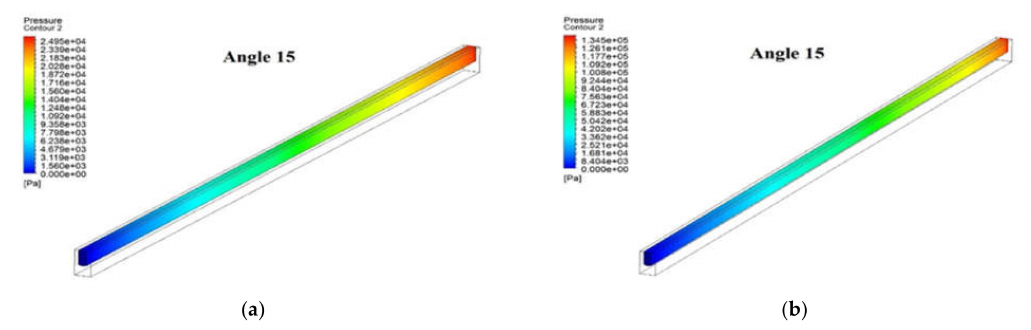
Figure 6. Pressure Contour in microchannel at ( a ) Reynolds Number = 200 and ( b ) Reynolds Number = 900.